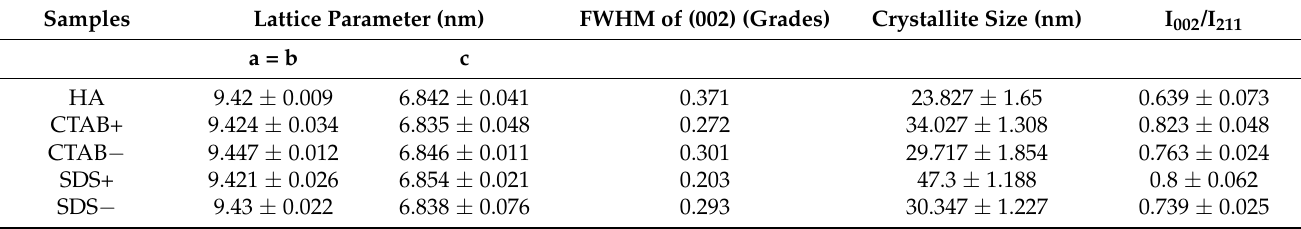
* The averages and standard deviations of the lattice parameter, crystallite size, and I 002 /I 211 ratio were computed using three repeated measurements. L/D ratio was obtained using 100 measurements, where the length and diameter from a particular particle were selected. The FWHM value corresponding to the (002) peak in Figure 1c only represents the values but the average crystallite size was obtained from three repeated measurements.